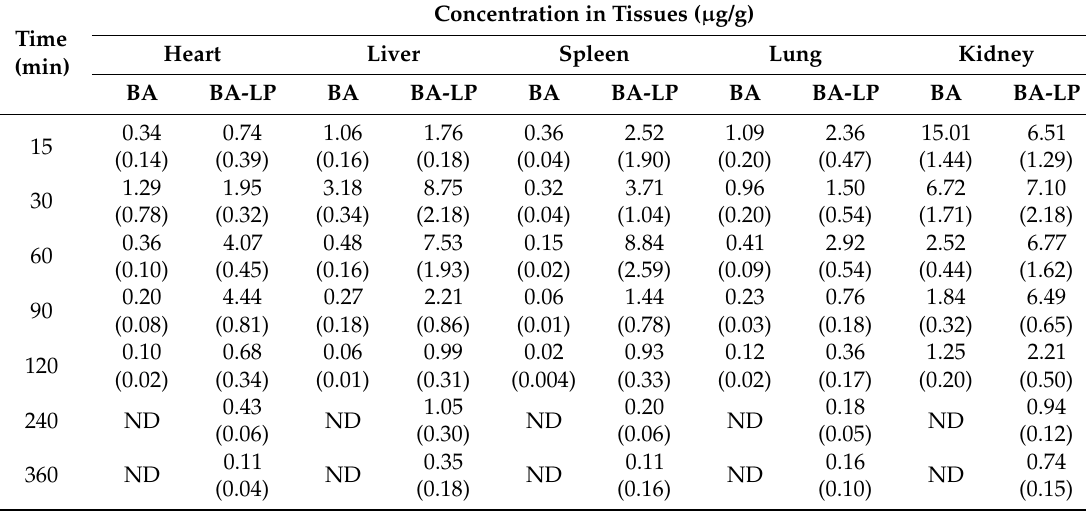
Table 4. The concentrations of BA in different tissues on normal models after i.v. administrated BA and BA-LP ( n = 5). Values are mean (SD).